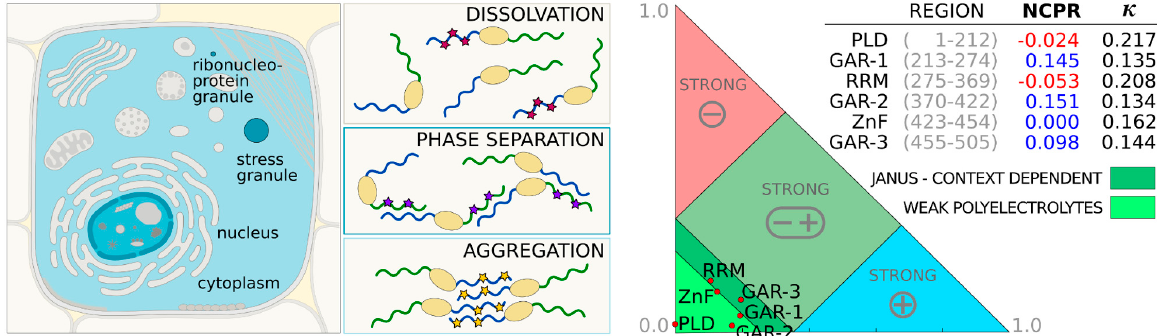
Figure 3. The left panel shows the cellular location of FUS (image source: BIAPSS). The protein is predominantly located in the nucleus. The physiological low levels of FUS found in the cytoplasm typically self-organize to membraneless compartments, such as stress granule or ribonucleoprotein granule. The aberrant disease-related aggregates are mostly localized in the cytoplasm. The methylation (purple stars) of C-terminal arginines (green tail) in the wild-type FUS strongly promotes phase separation and gelation. The phosphorylation (magenta stars) of serine and threonine in the N-terminus (blue tail) dissolve liquid-liquid droplets. The tyrosine-to-phenylalanine mutants (yellow stars) in the N-terminus and hypomethylation of arginines in the C-terminus increase aggregation. The right panel shows classification of intrinsically disordered ensemble regions (CIDER) [42] for the FUS sequence split into functional segments.